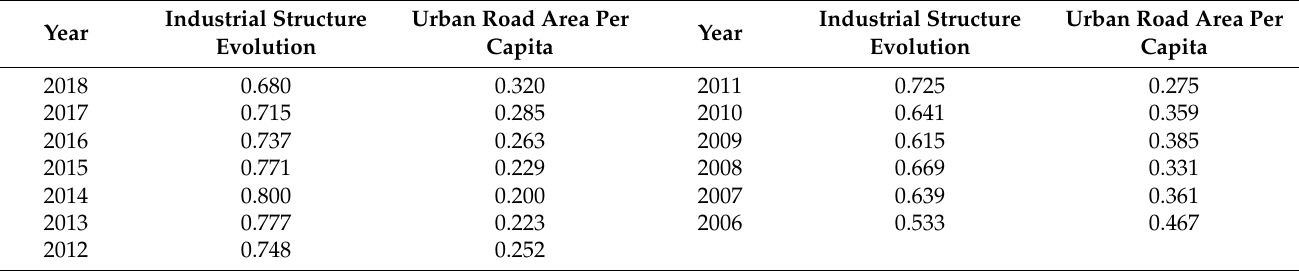
Table A3. Weight of urban function